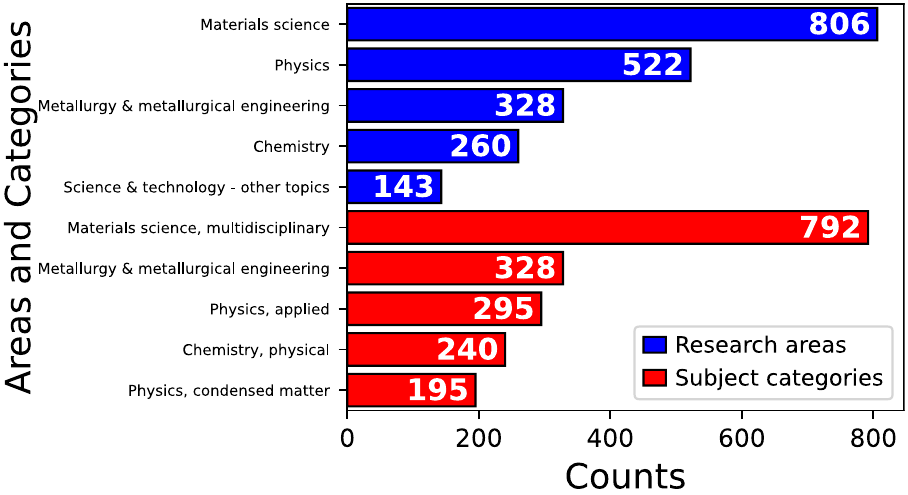
Fig. 4 Research areas and subject categories of the top ten journals in publications on MGs and classical MD simula-